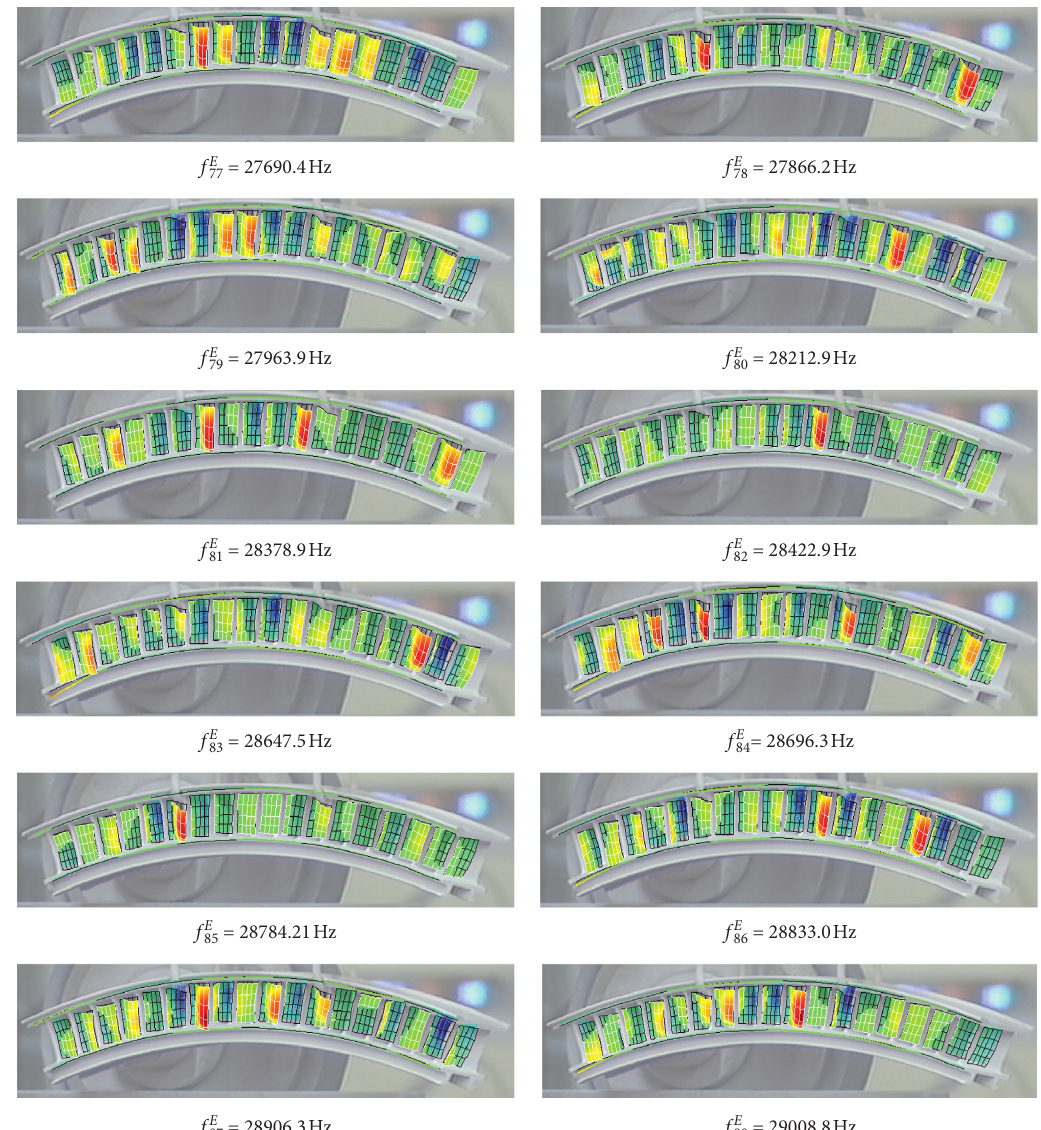
Figure 10: Natural frequencies and mode shapes for modes from 77 th to 88 th .